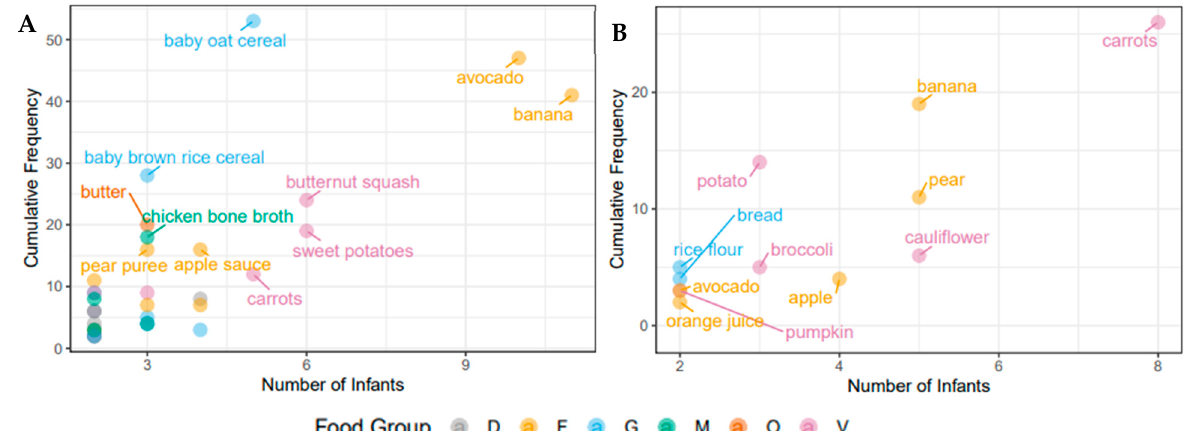
Figure 1. Individual food items consumed by the infants over the study period. ( A ) Baby, Food & Mi sub-study; ( B ) LucKi- Gut study. Only food items that were eaten by two or more infants are shown. Cumulative frequency describes overall intake of servings over the study period. The food groups shown here are dairy (D), fruit (F), grains (G), meat (M), oils (O) and vegetables (V).